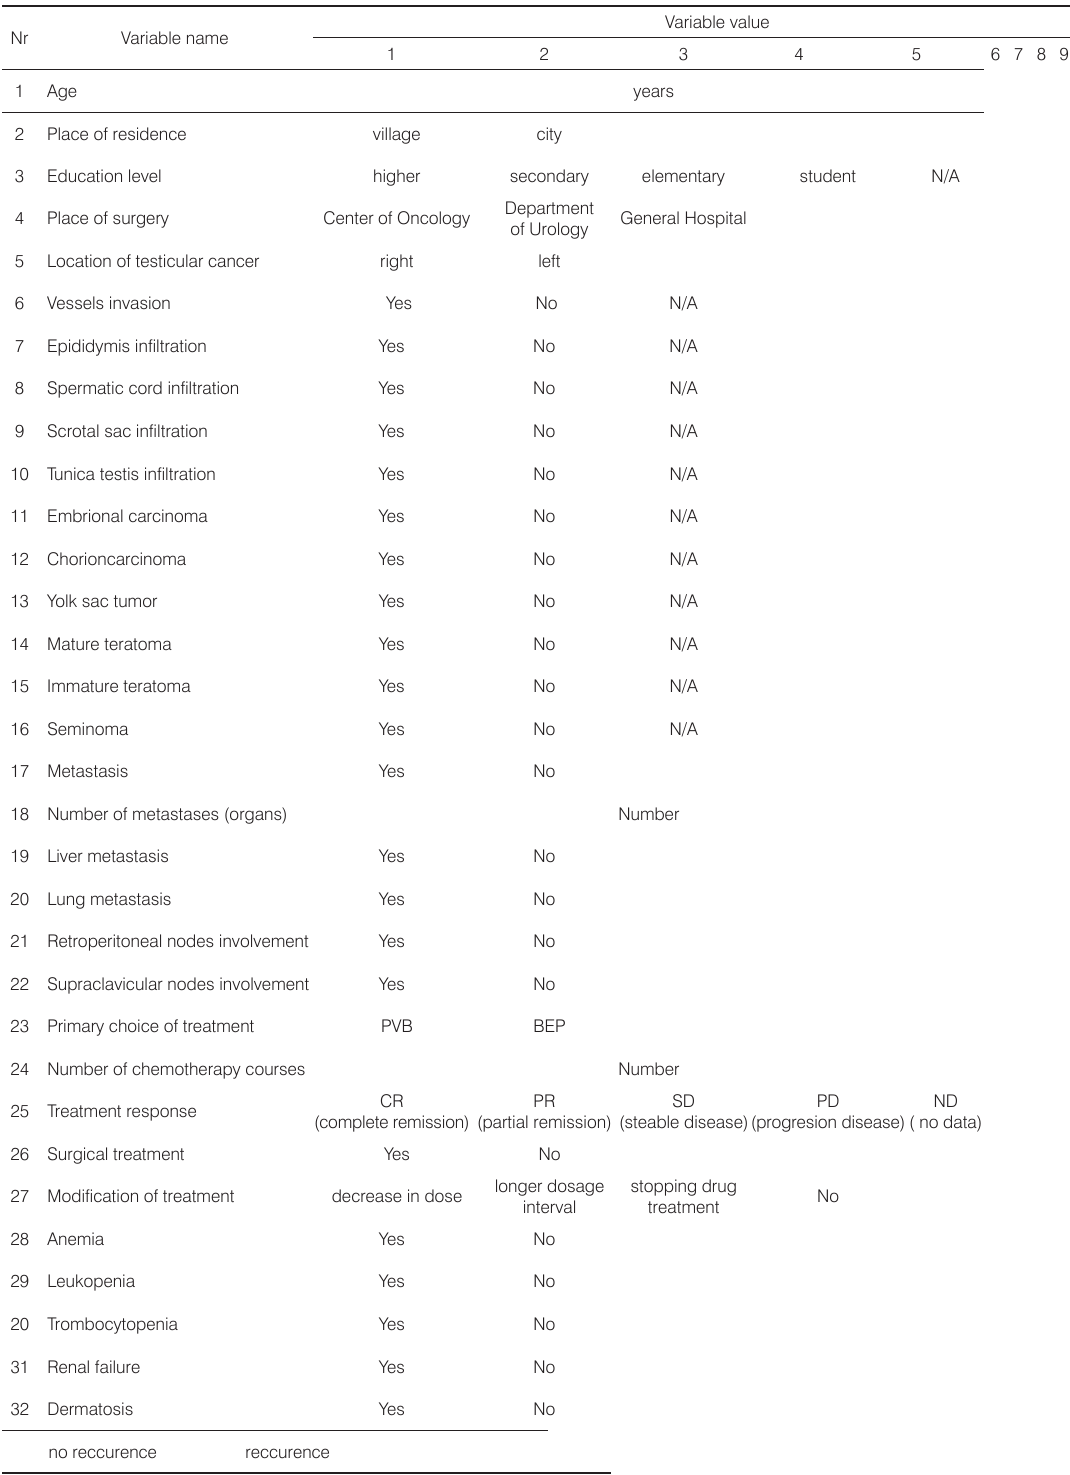
Table 1. Variables considered in the ANN